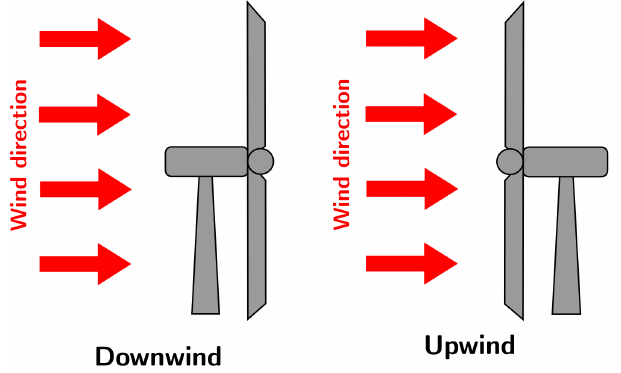
Figure 1. Upwind and downwind wind